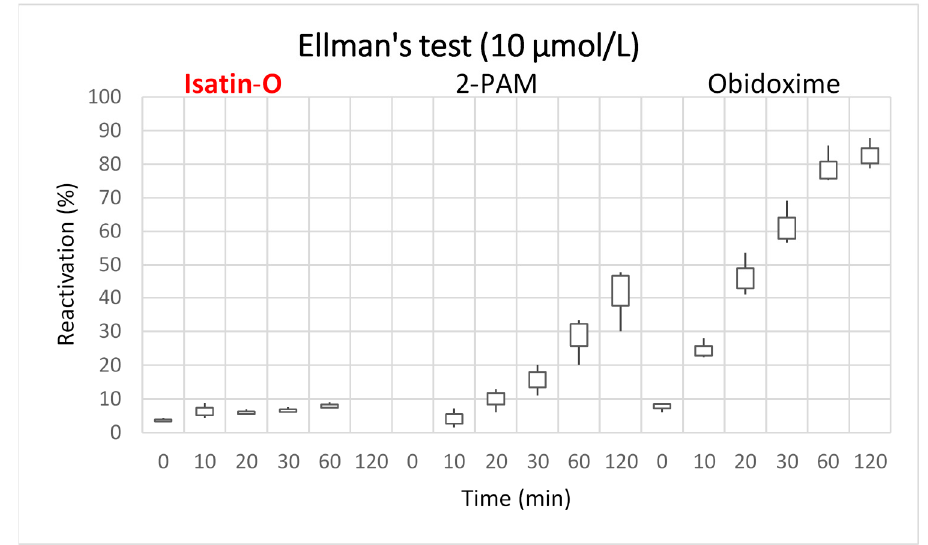
Figure 3. Reactivation efficacy of the oximes for Ee AChE/POX at 10 µ mol/L.